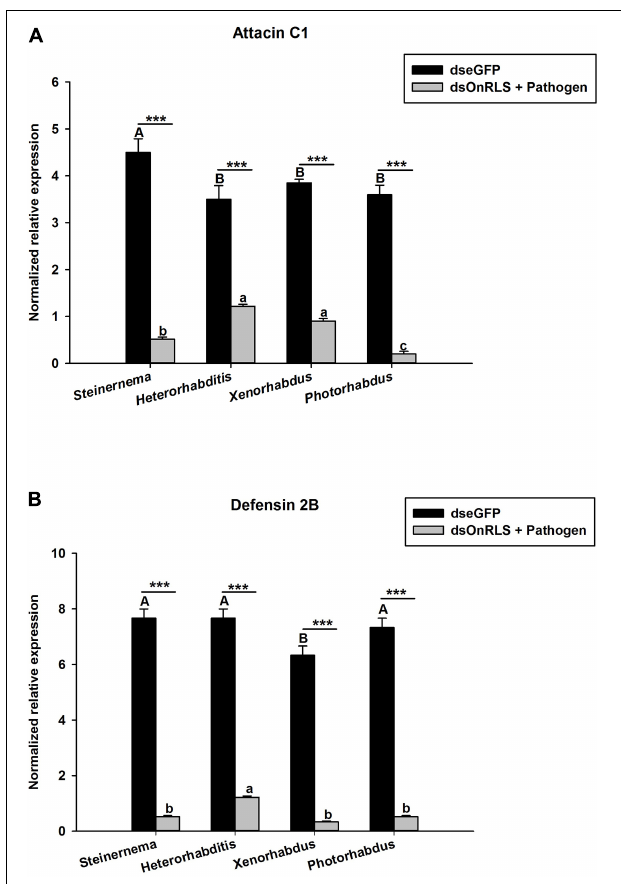
FIGURE 8 | Effects of OnRelish gene silencing on the transcription level of antimicrobial peptide gene; (A) Attacin C1 and (B) Defensin 2B in larvae of O . nipae after Microbial challenge. S.c. – S. carpocapsae , H.b. – H . bacteriophora , X. nematophila and P. luminescens . Error bars labeled with different letters are significantly different (one-way ANOVA followed by LSD test, p < 0.05). ∗∗∗ P < 0.0001 indicates significantly different levels between the control and microbial treatments at the indicated time period; while “ns” indicates no significant